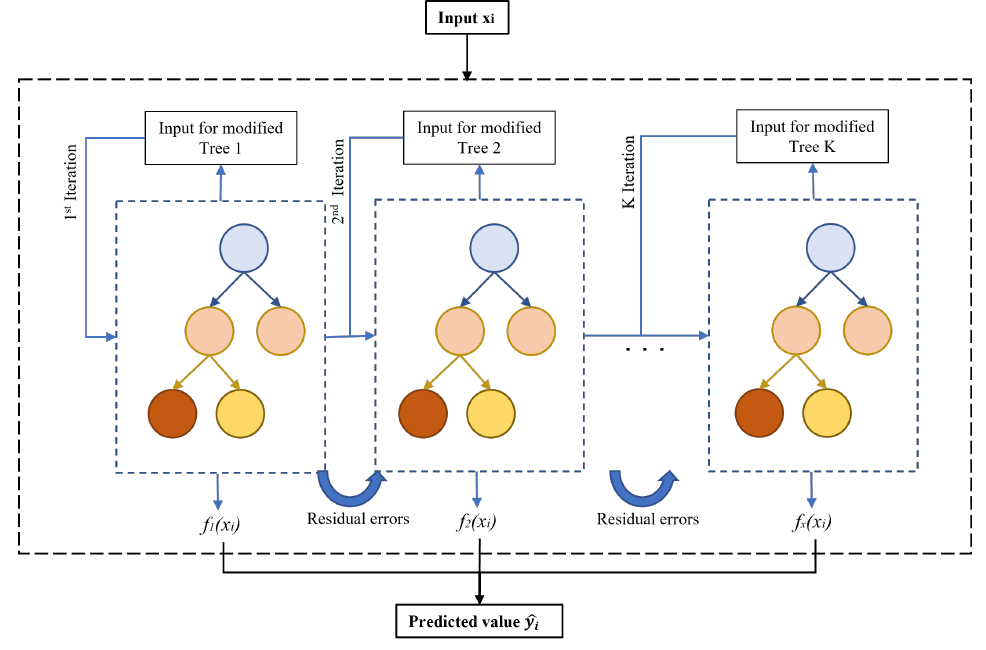
Figure 3. XGBoost approach